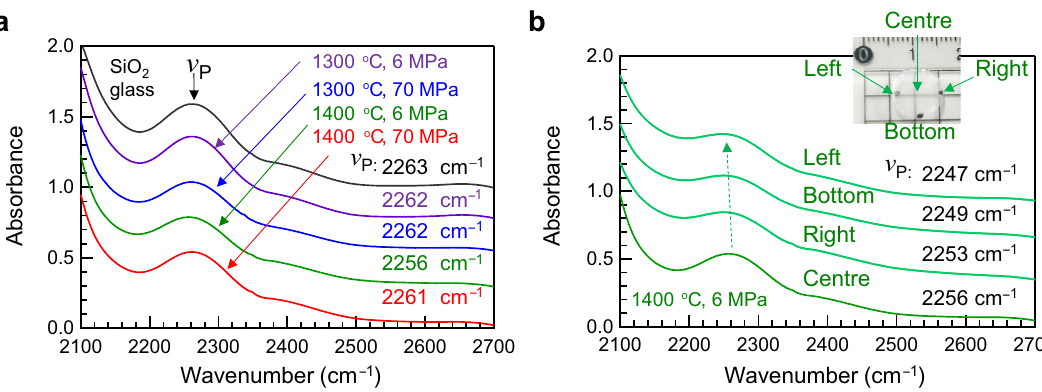
Figure 6. Spatial heterogeneity by micro-IR spectroscopy. ( a ) Micro-IR spectra of SPS-SiO 2 and SiO 2 glasses obtained from the centre. ( b ) Enlarged micro-IR spectra obtained from different positions of the SPS-SiO 2